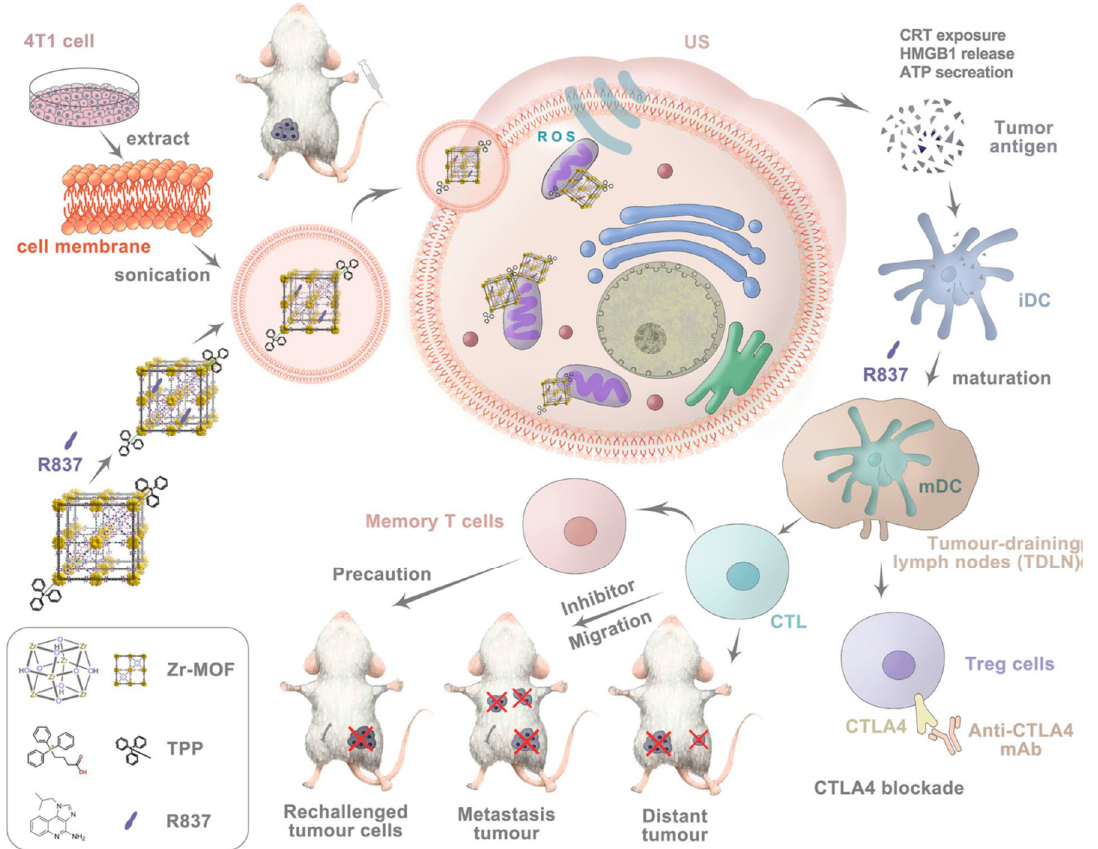
Figure 11. Schematic illustration of mechanism of mitochondria ‐ targeted cancer cell membrane biomimetic metal–organic framework mediated sonodynamic therapy and immune checkpoint blockade immunotherapy. (Reprinted from [115], license CC BY 4.0.)